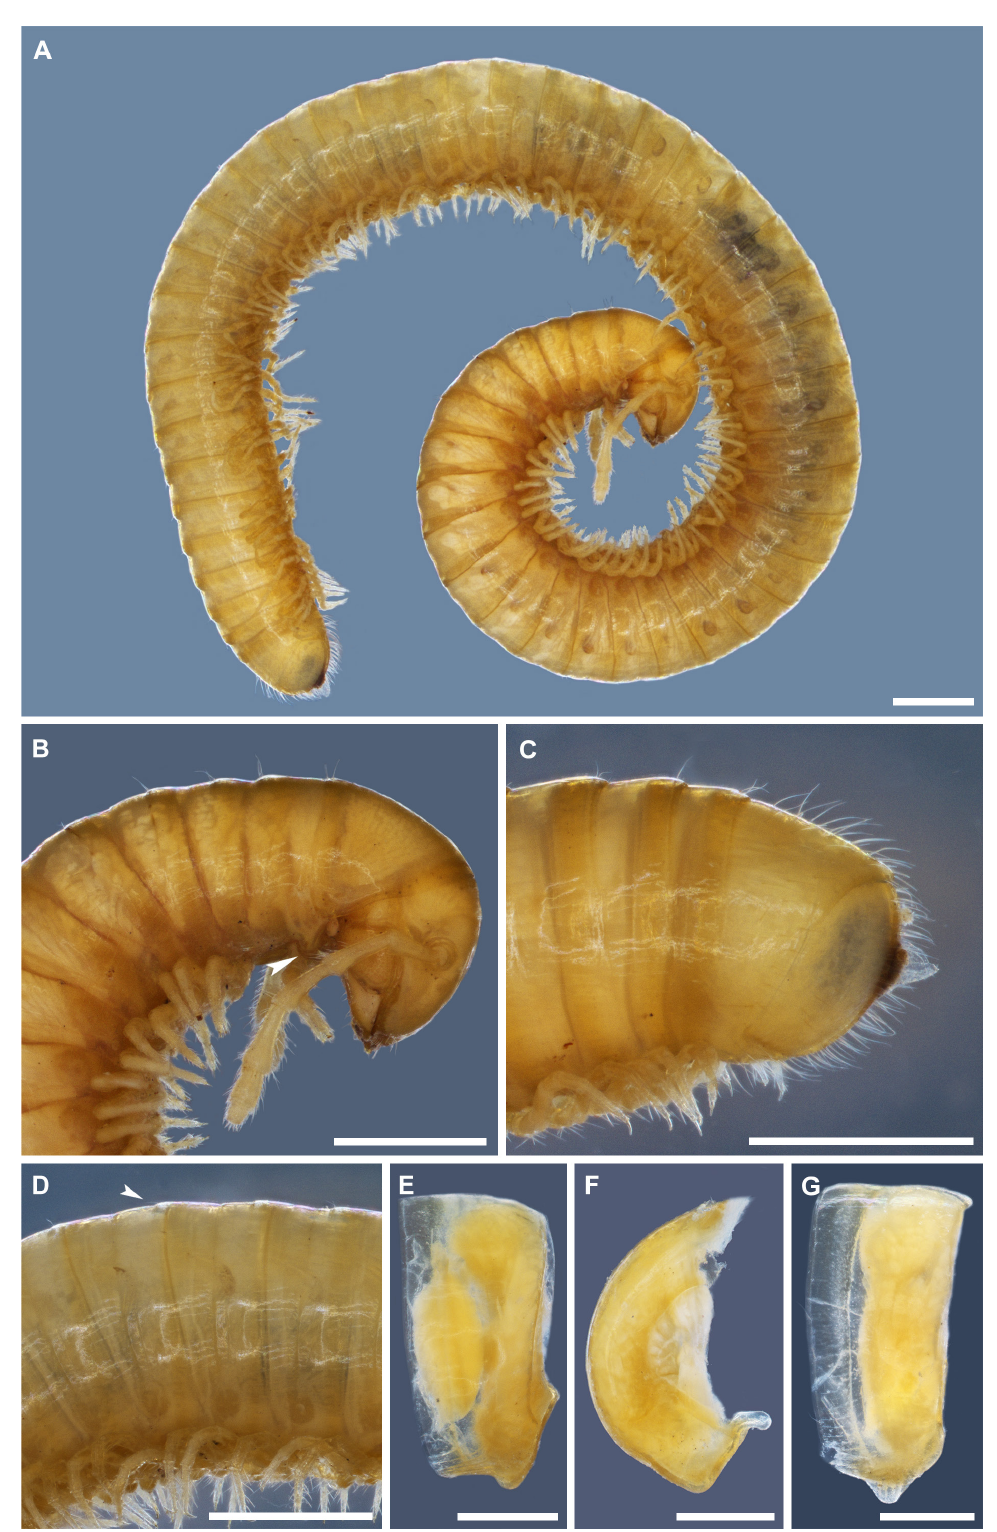
Fig. 22. Leucogeorgia golovatchi sp. nov., type ♂♂ from Tsakhi Cave (ZMUM) (A–D: holotype; E–G: paratype). A . Habitus, lateral view. B . Anterior part of body, lateral view. C . Posterior part of body, lateral view. D . Midbody rings, lateral view. E . Body ring 2, lateral view. F . Body ring 2, anterior view. G . Body ring 7, lateral view. Scale bars: A–D = 1 mm; E–G = 0.5